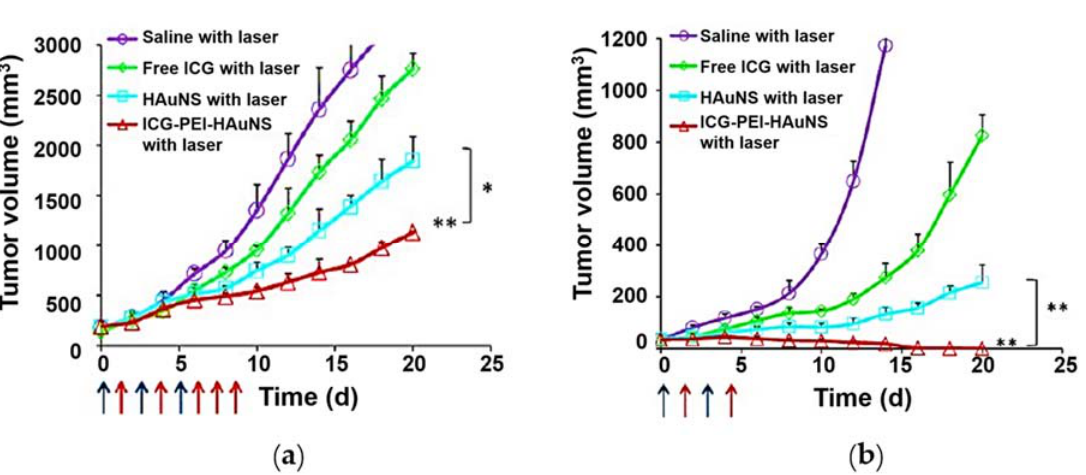
Figure 5. Anti-proliferative efficacy in vivo. ( a ) Tumor growth curves for mice bearing CT-26 tumors treated with saline, free ICG, HAuNS, or ICG-PEI-HAuNS, n = 6. The blue arrow indicates injection, and the red arrow indicates the laser exposure (1 W/cm 2 , 2 min, 120 J/cm 2 ). ( b ) Inhibition of tumor metastasis. Tumor growth curves for mice bearing B16 tumors treated with saline, free ICG, HAuNS, or ICG-PEI-HAuNS, n = 6. The blue arrow indicates the injection, and the red arrow indicates the laser exposure (1 W/cm 2 , 2 min, 120 J/cm 2 ). Reproduced from Ref. [113], with permission from American Chemical Society, 2017.